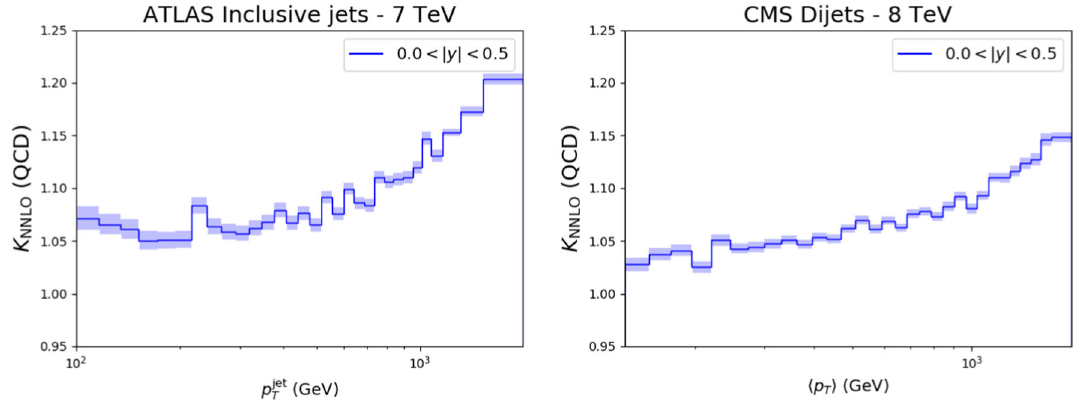
Fig. 4 The NNLO QCD K -factors for the central rapidity bins of the ATLAS 7 TeV single-inclusive jets (left) and CMS 8 TeV dijets (right), with the Monte Carlo numerical uncertainties shown as filled bands around the central